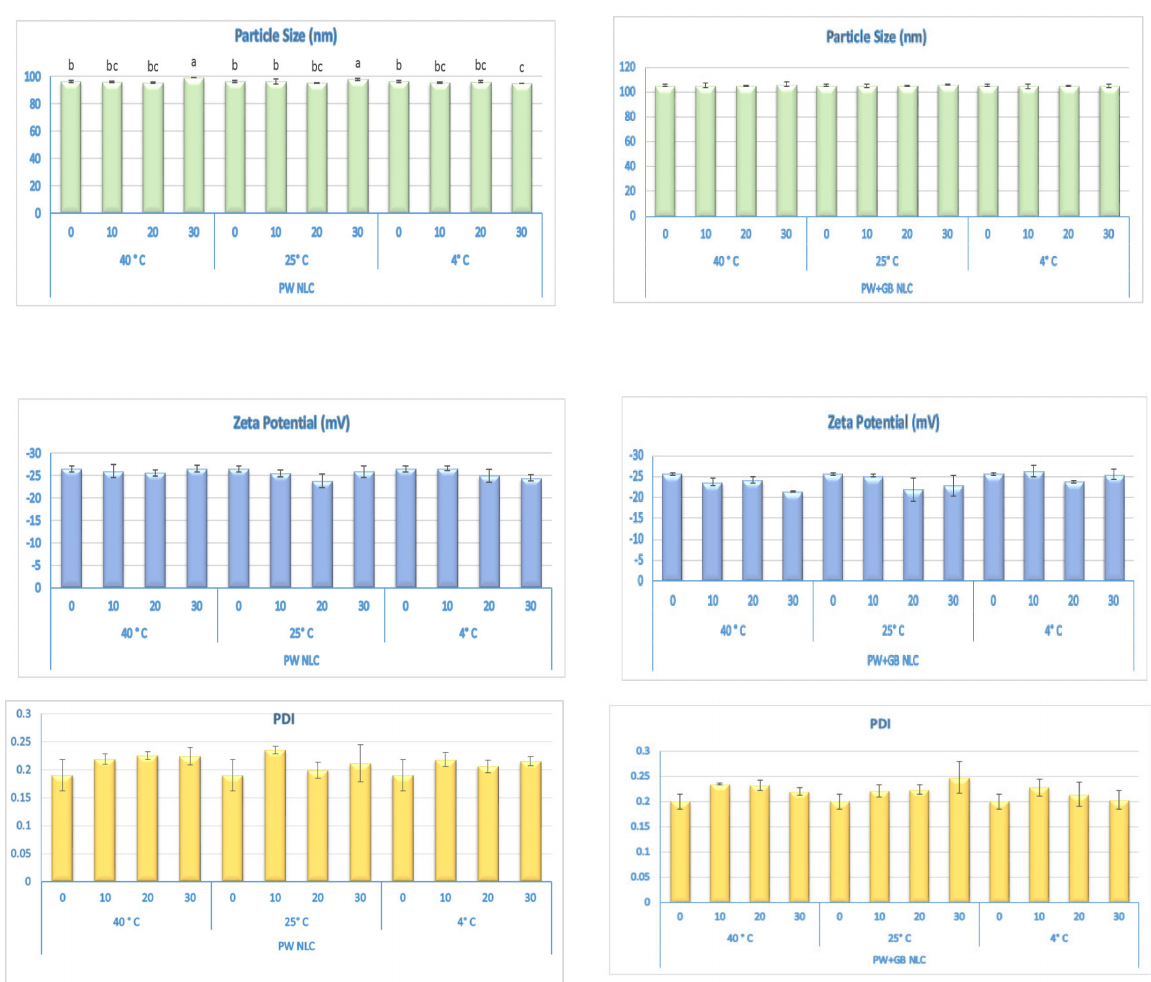
Figure 1. E ff ects of storage on the physical stability of β -sitosterol NLC dispersions at di ff erent temperatures (4, 25 and 40 ◦ C) over time. In each parameter, the means that have no superscript in common are significantly di ff erent from each other ( p ≤ 0.05). The means without superscript are not significantly di ff erent ( p > 0.05). PW and PW + GB represent the NLCs formulated with propolis wax alone or its binary mixture with glyceryl behenate (1:1),